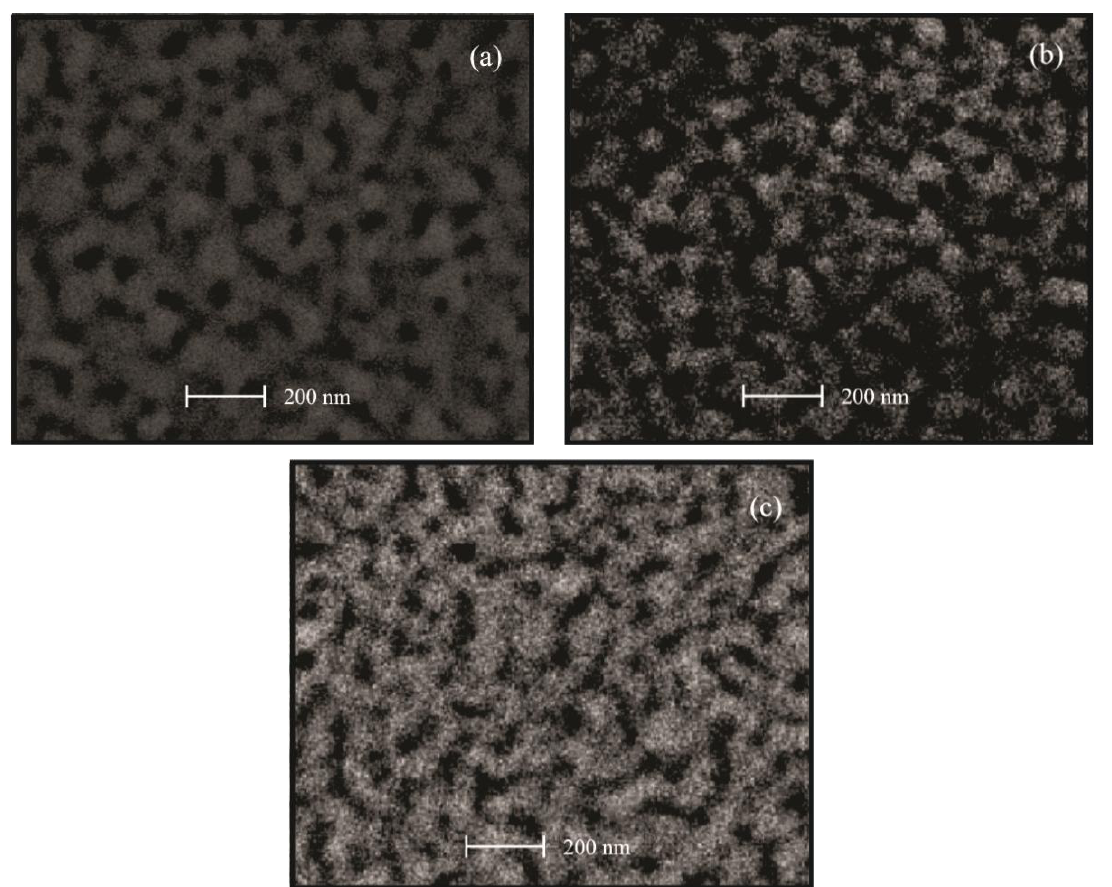
Figure 4. SEM images of ZnO:Ru films with different immersions number: ( a ) one, ( b ) three, and ( c ) five